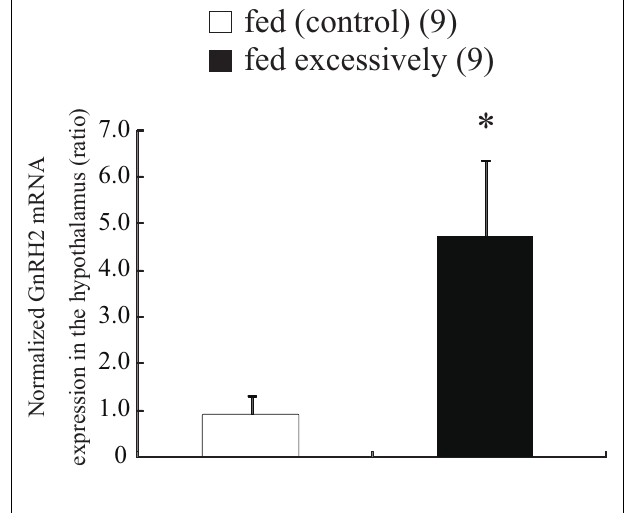
FIGURE 3 | Effect of feeding condition on the level of expression of GnRH2 mRNA in the hypothalamus. The results are expressed as the mean ± SEM, and the number of fish per group is indicated in parentheses. Statistical significance was evaluated by Student’s t -test (** P <